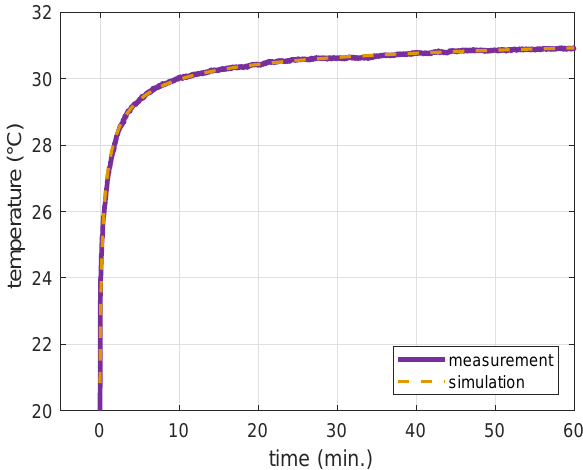
Figure 4. Example of fitted simulation profile using heat transfer coefficient of h = 308 W m − 2 K − 1 over the measurement profile.